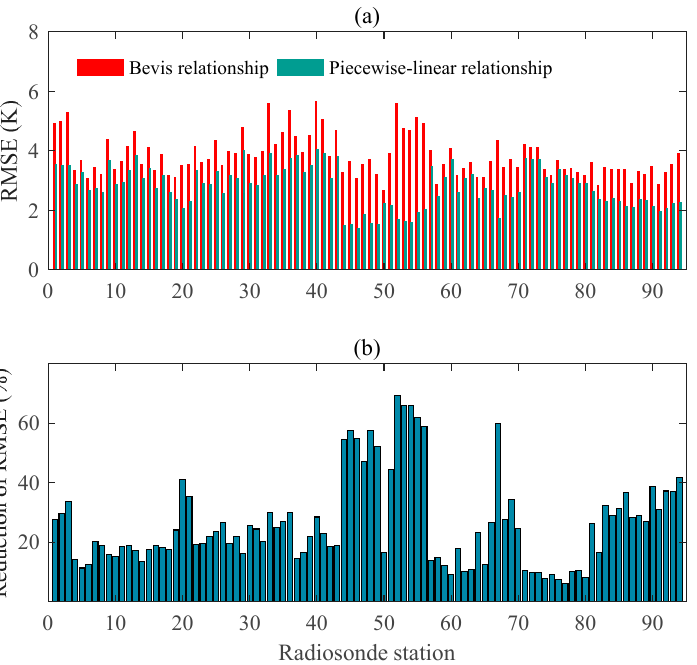
Figure 5. RMSE (K) ( a ) and accuracy improvement of the T m ( b ) calculated by the site-specific piecewise-linear and Bevis T m - T s relationship.